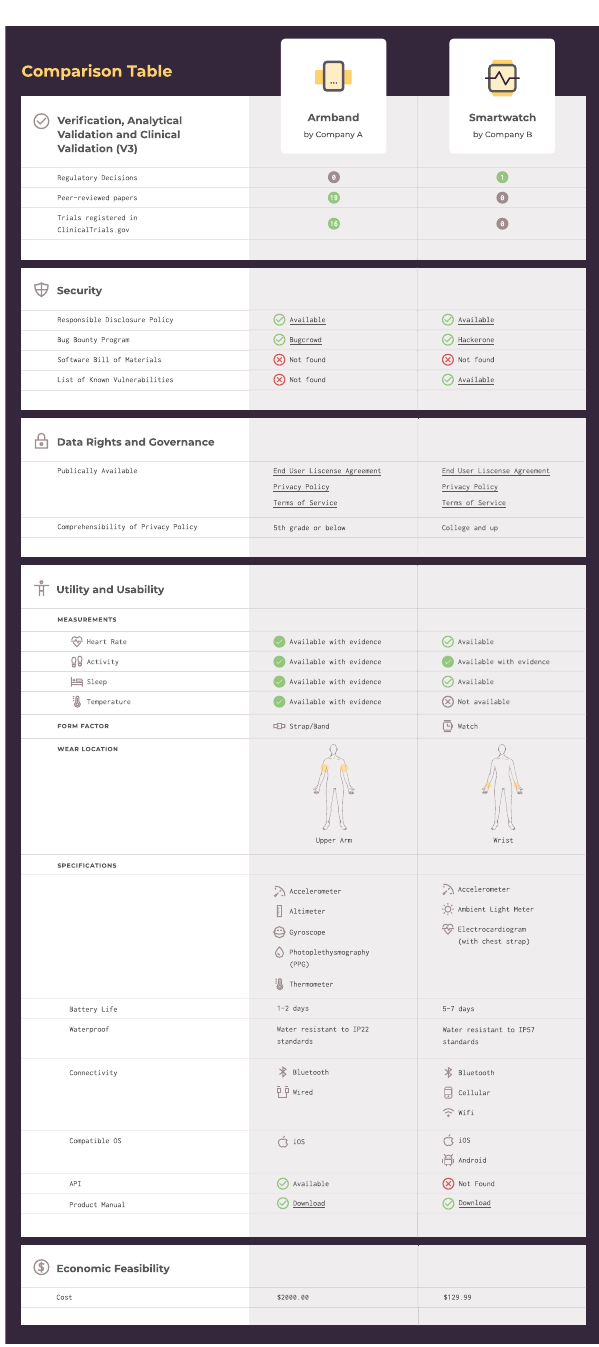
Fig. 4 Connected sensor comparison table. This is an example of how sensors might be compared in a side by side visualization that incorporates dimensions from the proposed evaluative framework. In this illustrative visualization, additional detail and metrics are provided for the utility and usability dimension, in order to facilitate a rapid evaluation for appropriateness within an intended